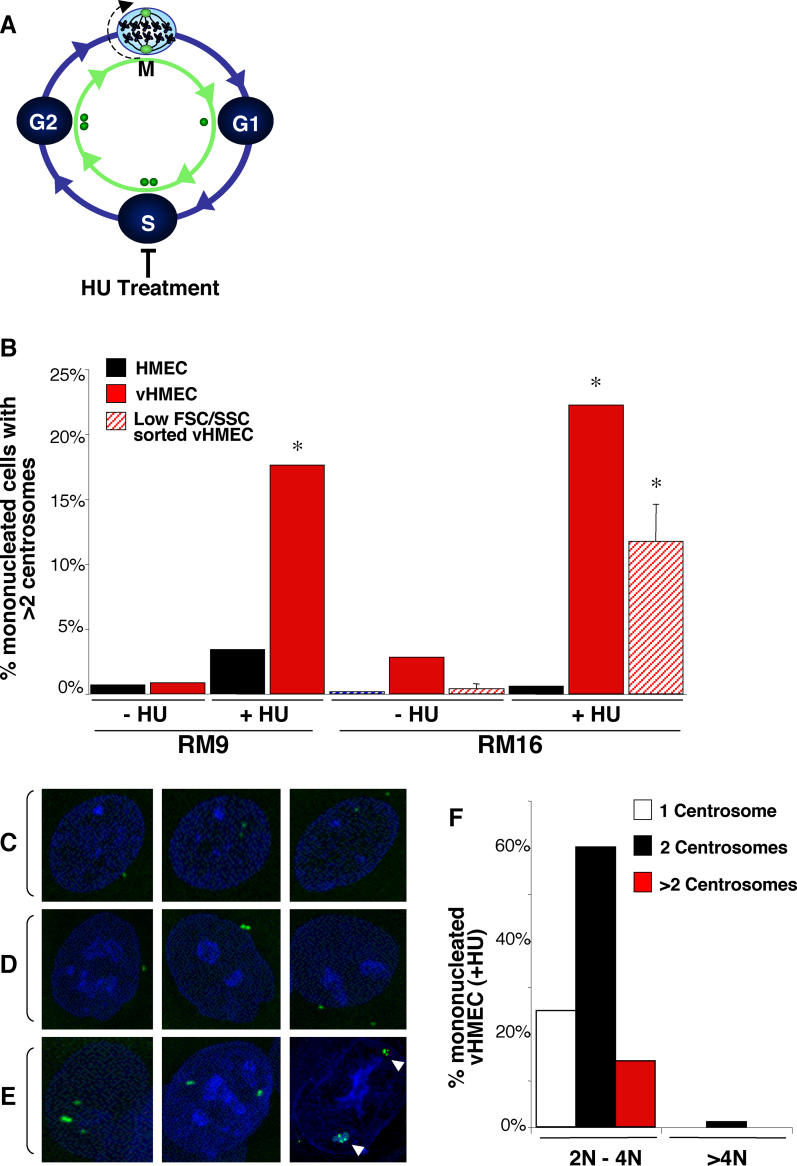
Centrosome Duplication Is Uncoupled from DNA Replication in vHMECs(A) Schematic of the centrosome duplication cycle (interior, green) in relation to the DNA replication cycle (exterior, blue). Each daughter cell inherits one copy of the DNA and one centrosome (G1 phase of the cell cycle). Centrosomes (small, green circles) begin duplication at the same point as when DNA replication is initiated (S phase of the cell cycle). Following duplication and maturation of the centrosome, the two centrosomes separate and migrate to opposite poles during early M (mitosis).(B) Analysis of mononucleated cells with more than two centrosomes in HMECs (black: RM9 [5 PD], RM16 [less than 4 PD]), early-passage vHMECs (red: RM9 [21 PD], RM16 [7 PD]), and low FSC/SSC sorted vHMECs (blue: RM16 [17 and 30 PD]) untreated (−HU) or exposed to HU (+HU).(C–E) Examples of normal centrosome numbers in HMECs (C) and vHMECs (D) and more than two centrosomes in vHMECs (E).(F) Early-passage vHMECs (RM9 [14 PD] and RM16 [17 PD]) that were exposed to HU were stained with an antibody recognizing γ-tubulin and with PI (DNA counterstain), and the DNA content of each nucleus was measured by quantitative immunofluorescence microscopy. Cells were classified as having 2N to 4N (diploid) or more than 4N (polyploidy) DNA content. The centrosome number of each cell was correlated to the DNA content of that cell. Analysis included 100 to 200 cells (excluding binucleated cells). *Statistical significance (p < 0.005) based on comparison of −HU and +HU experiments.